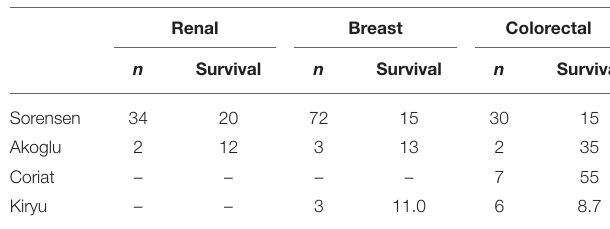
TABLE 1 | The relationship between the number of primary site cases and survival